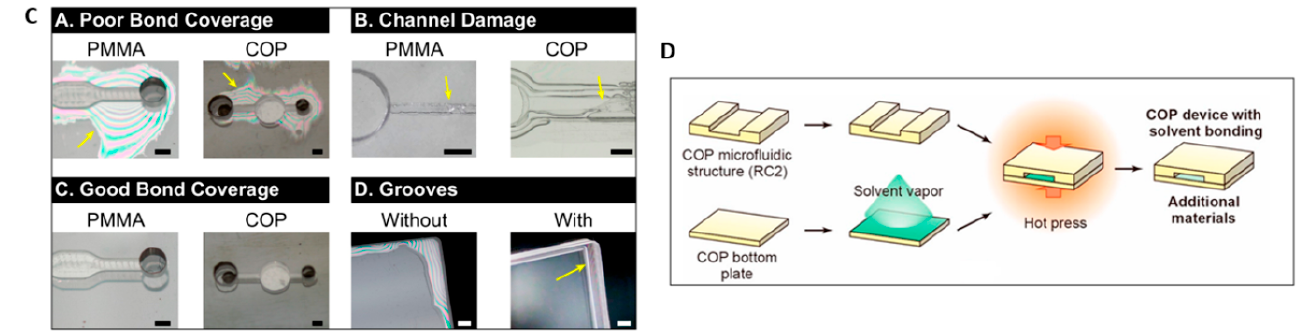
Figure 3. ( A ) ( a ) Schematic diagram of UV-assisted liquid solvent bonding process. ( b , c ) Chemical reaction on PMMA substrates after solvent and UV treatment. Reprinted with permission from ref. [53]. Copyright 2020 American Chemical Society. ( B ) Bonding strength at different chemical composition of chloroform and ethanol [54]. ( C ) Different defects in solvent bonding and solutions. Reprinted with permission from ref. [55]. Copyright 2017 JoVE ( D ) Schematic of the